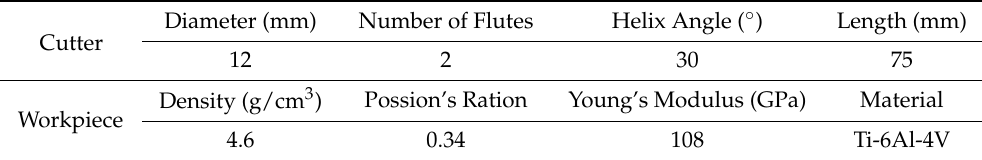
Figure 6. Configuration of the experiments. Table 1. The properties of the workpiece and the specifications of the cutter.